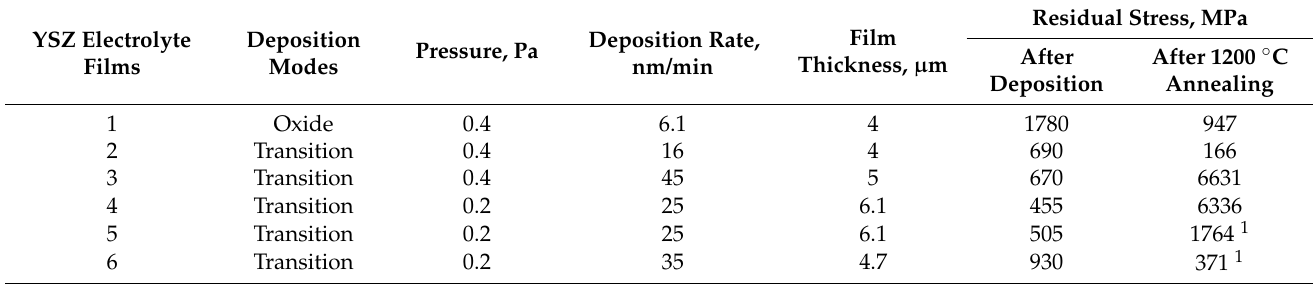
Table 1. Deposition process parameters and residual stresses for YSZ electrolyte